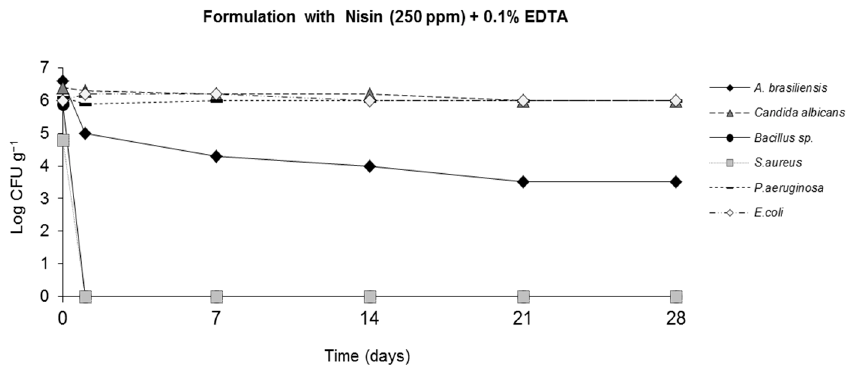
Figure 2. Growth inhibition of different microorganisms in body milk formulation with preservative system nisin 250 ppm + 0.1% EDTA.